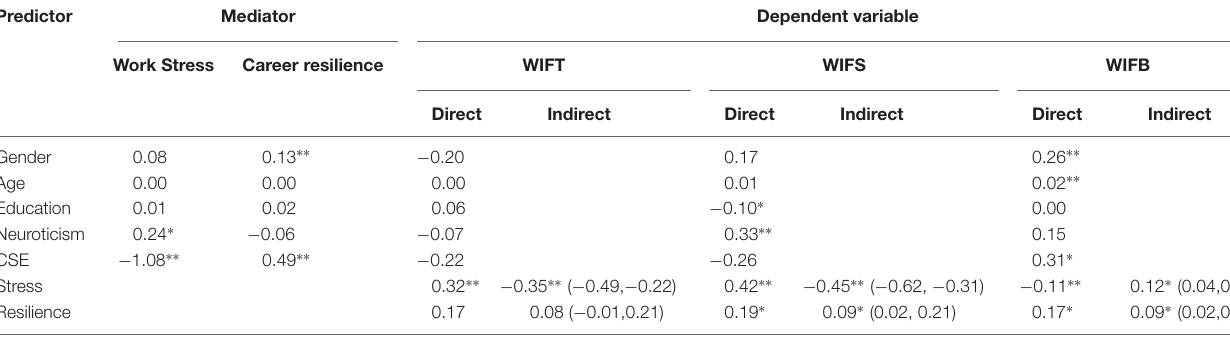
TABLE 2 | Direct and indirect effect and the associated 95% confidence intervals.